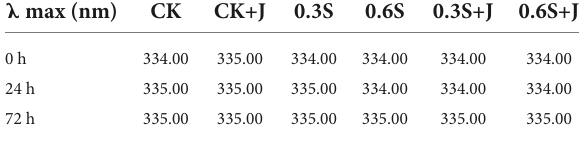
TABLE 4 λ max of intrinsic fluorescence spectroscopy of post-mortem chicken myofibrillar protein from selenium yeast and jujube powder dietary